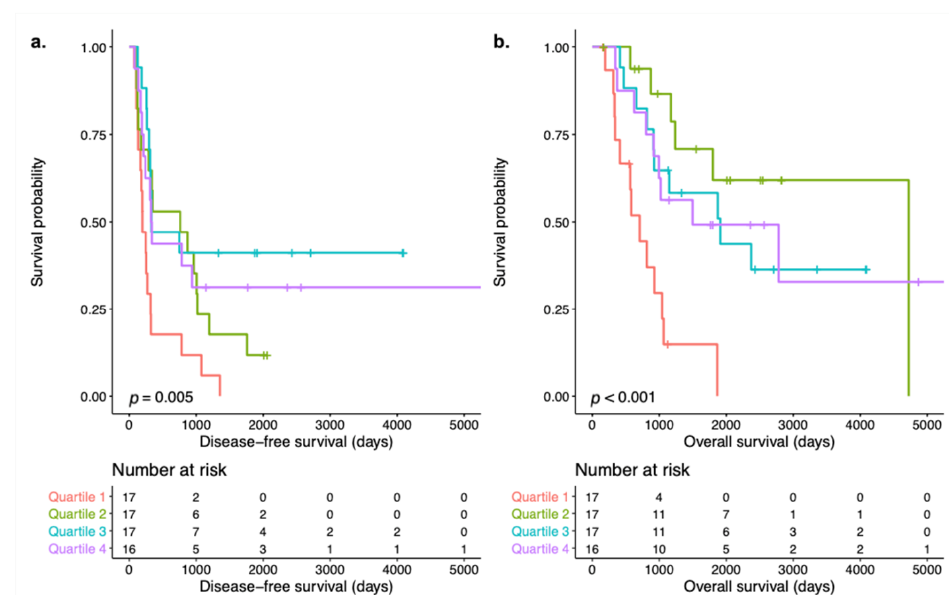
Figure 3. Kaplan–Meier survival analysis with log-rank tests and number at risk tables of subgroups based on quartiles of ER pathway activity in postmenopausal high-grade serous ovarian carcinoma. ( a ) Disease-free survival curves. ( b ) Overall survival